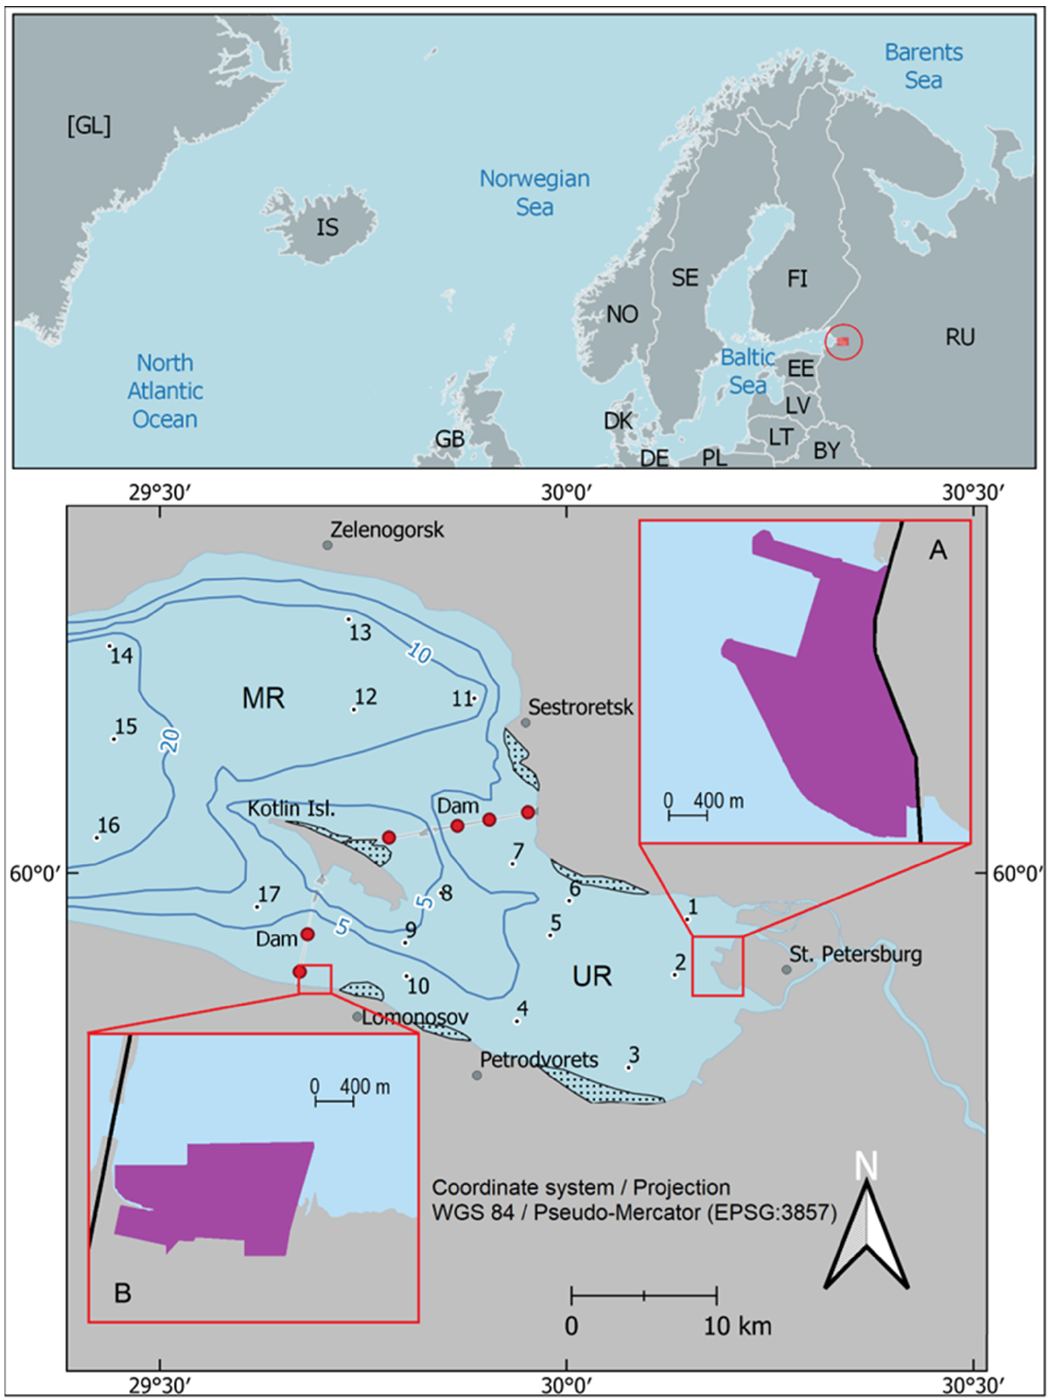
Figure 1. The upper (UR) and middle (MR) reaches of the Neva Estuary with an indication of sampling stations (1–17) and new lands (violet) created in 2006–2007 ( А ) and 2014–2015 ( B ). Blue lines: isobaths of 5, 10, and 20 m. Areas with dots indicate dense reeds. Dam—the St. Petersburg Flood Protection Facility. Red points—Dam sluices. The red circle in the top section is the location of the Neva Estuary. Two-letter country codes are given according to ISO 3166-1 alpha-2 [32].